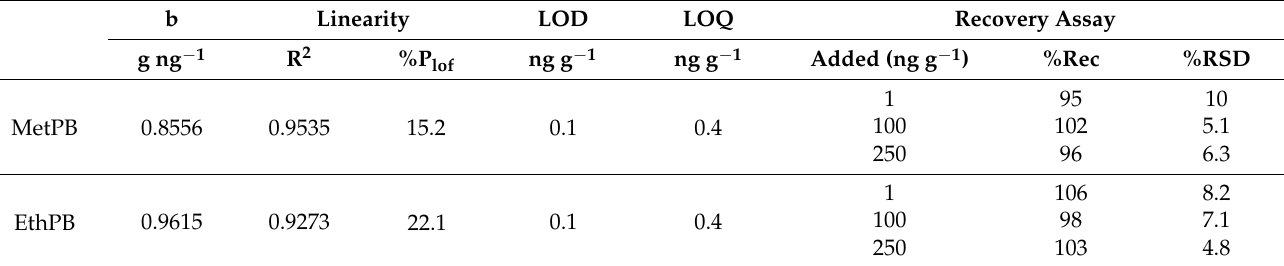
Table 2. Validation and quality parameters of the method.